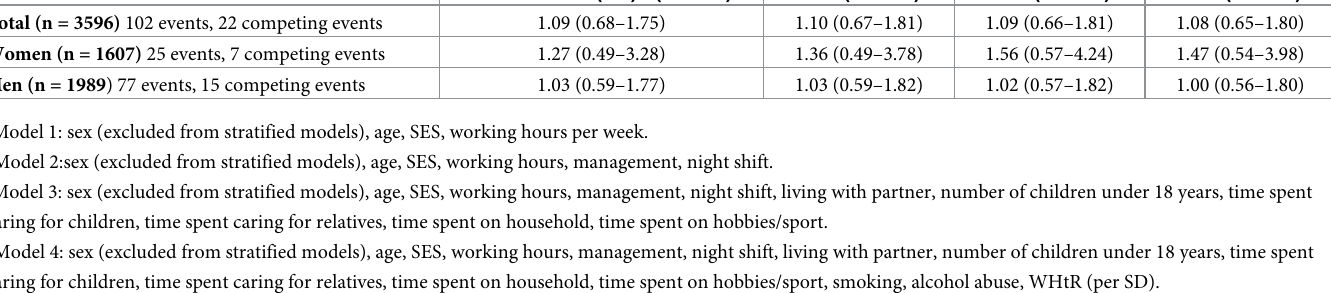
Table 5. Hazard ratios (HR) and 95% confidence intervals (CI) for incident CVD and WLC scores exceeding 60 (of 100) from competing event analysis (competing event = non-CVD deaths).